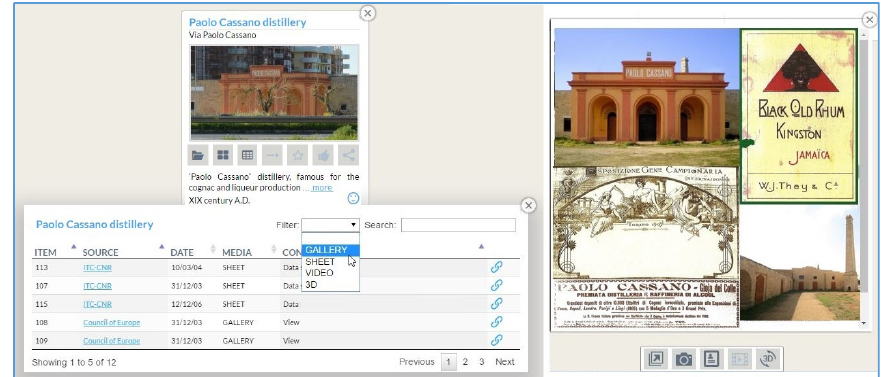
Figure 8. The interactive map—”Table” window ( left ) with filter and search functions called from the callout (in background) and “Tile” window ( right ).